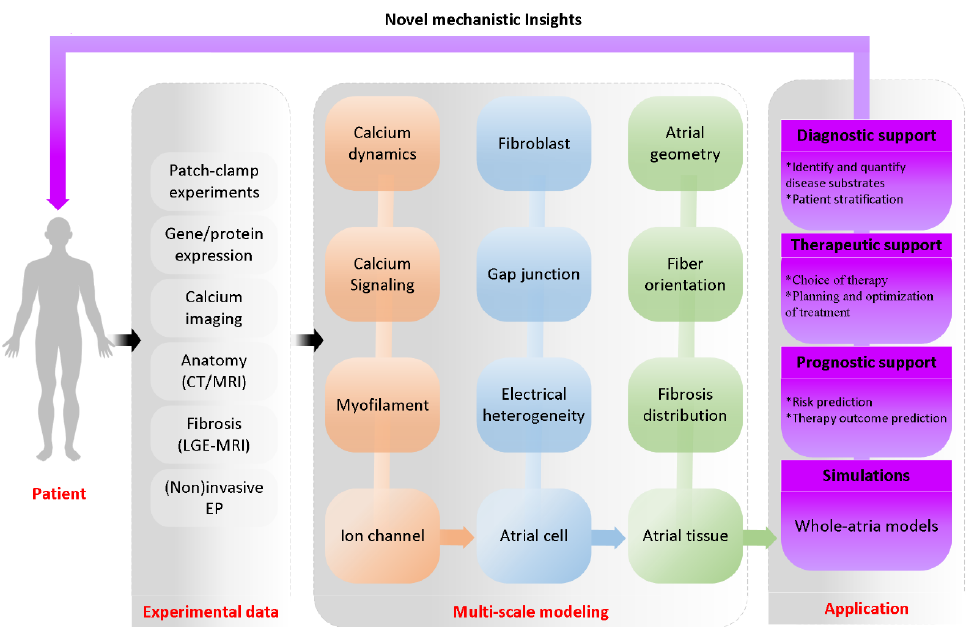
Figure 5. Schematic overview of multi-scale atrial modeling and simulation of 3D virtual human atria. A computational model of the 3D human atria enables synergistic integration of multiple experimental data obtained with the use of different clinical modalities (such as CT, MRI, LGE-MRI, electrocardiography, genetics, proteins and membrane potential measurements) in one personalized heart simulation. The integrative nature of such a virtual-human atria simulation adds value to the existing clinical workflow by offering more quantitative and objective insight into the underlying AF substrates of a patient. In addition, the model provides a platform for virtual evaluation and optimization of a therapy